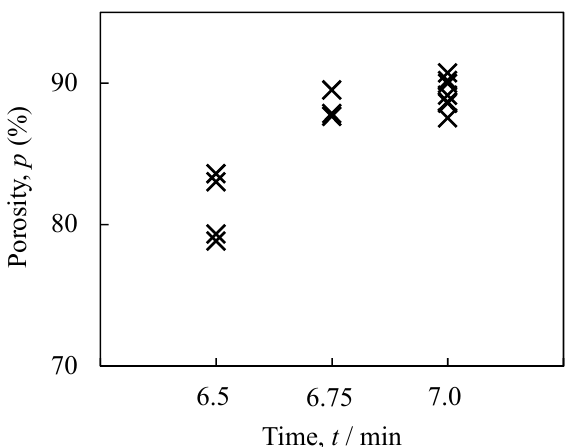
Figure 6. Relationship between porosity and foaming time of obtained Al foam-filled steel tube compression test specimens.